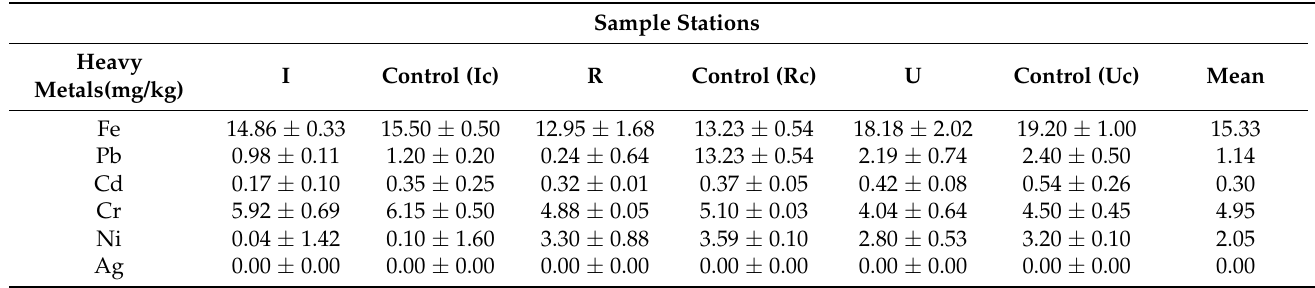
Table 2. Mean concentration of heavy metals in Vernonia Amygdalina of campuses (I, R, U). Sample